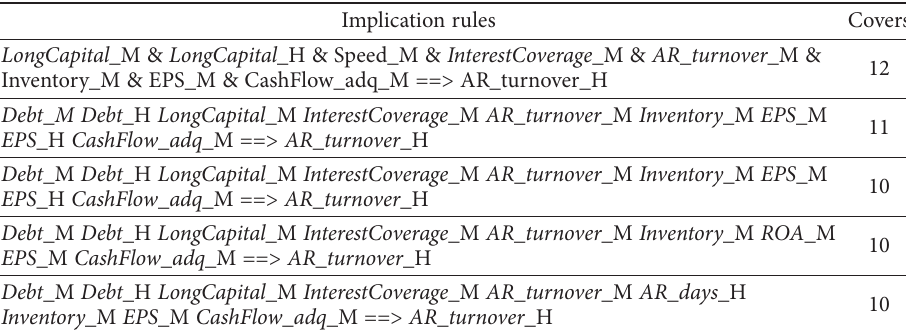
Table 5. Implication rules associated with high AR_turnover Implication rules